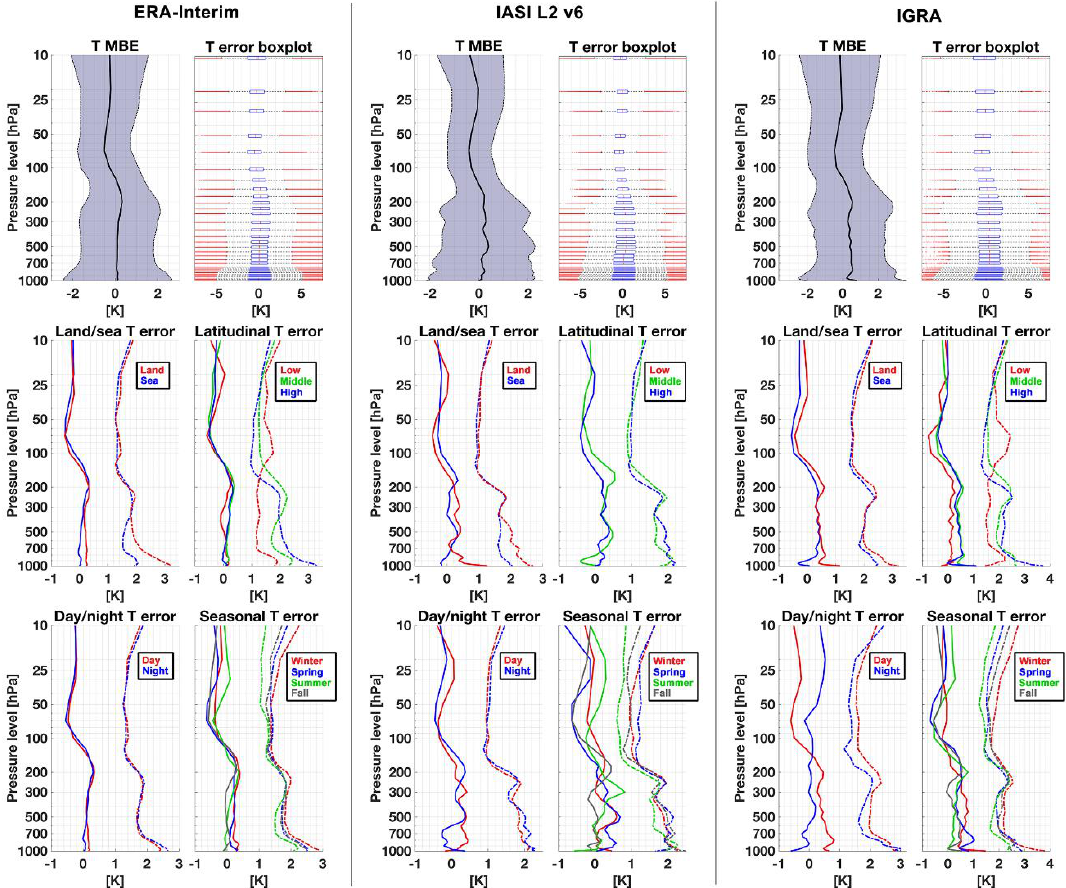
Figure 8. Top panels: T MBE with the STD and error boxplots for ERA-Interim ( left ), IASI L2 v6 ( center ), and IGRA ( right ) separately. Middle and bottom panels show MBE (solid lines) and RMSE (dashed lines) for land/sea surface, high/middle/low latitude, day/night, and the four seasons. The 2017 validation dataset is used to compute the statistics.